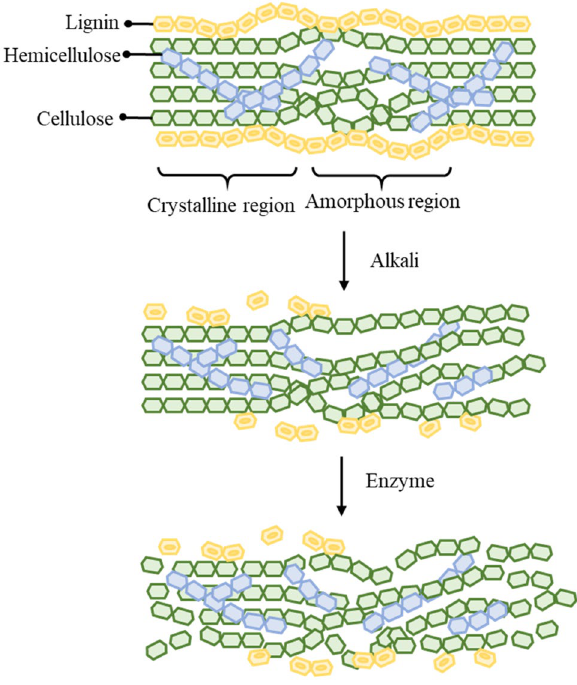
Figure 15. The hypothetical reaction mechanisms of alkali and enzyme with rice straw lignocellulose 16,17,21